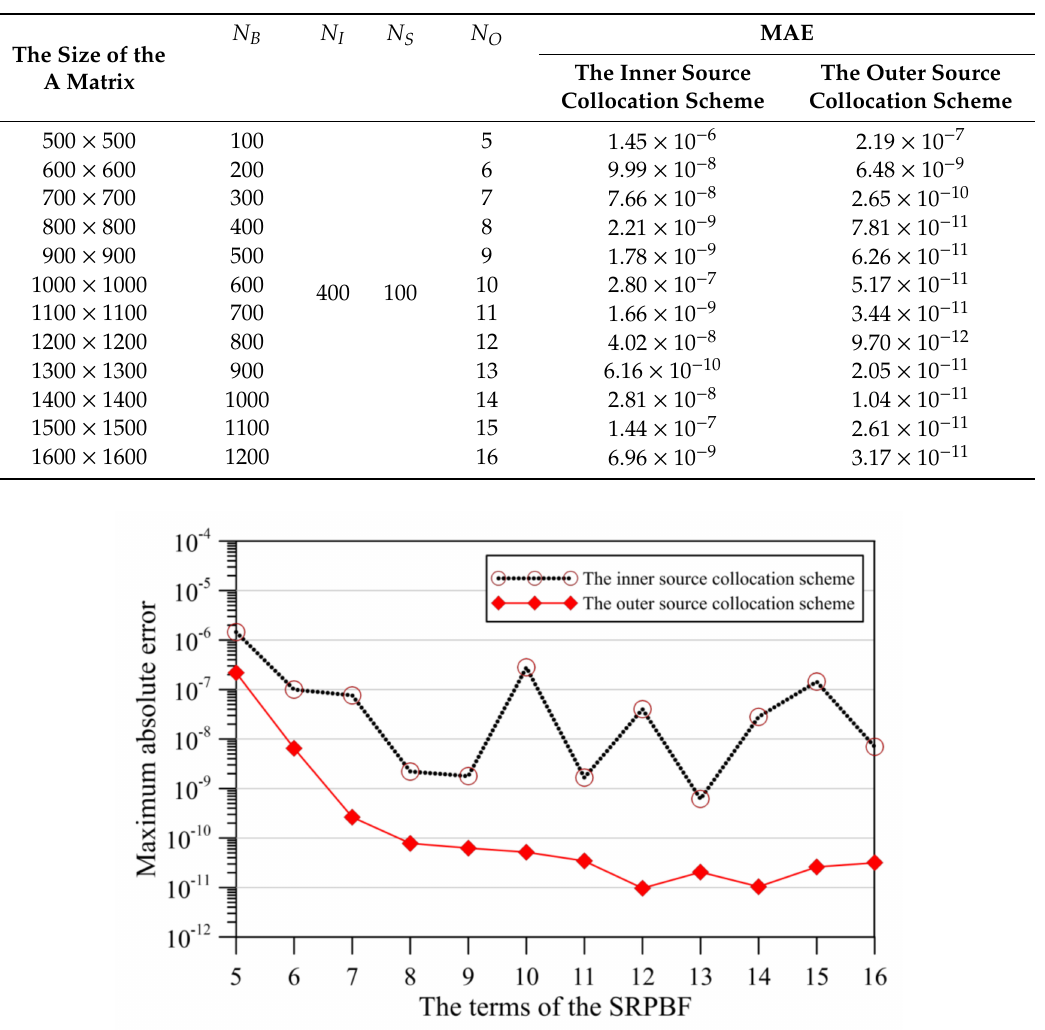
Table 1. The maximum absolute error (MAE) of the proposed approach with the consideration of two source collocation schemes.